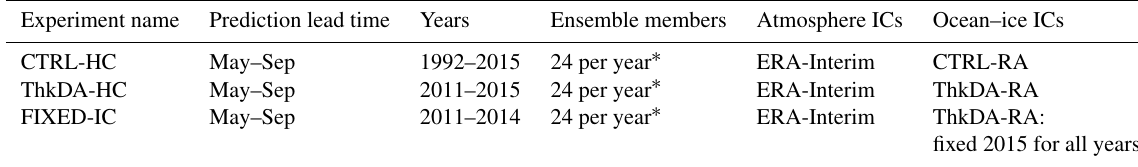
Table 2. Details of GloSea coupled seasonal prediction experiments (or “hindcasts”) used in this